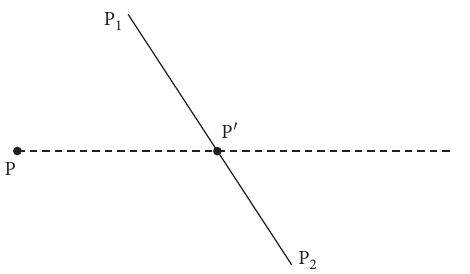
Figure 5: The target point P intersects the edge (P)